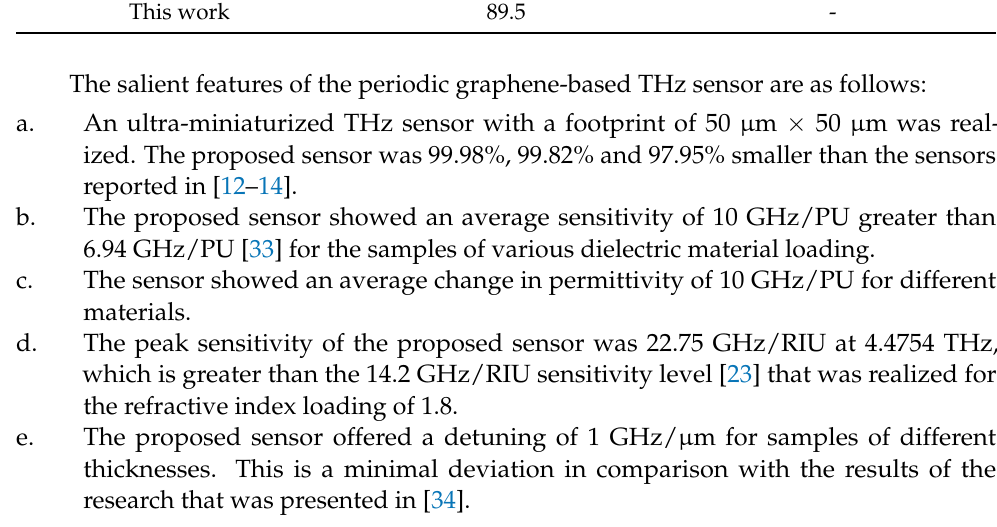
Table 4. Comparison of Q factor with other relevant THz graphene-based sensors.